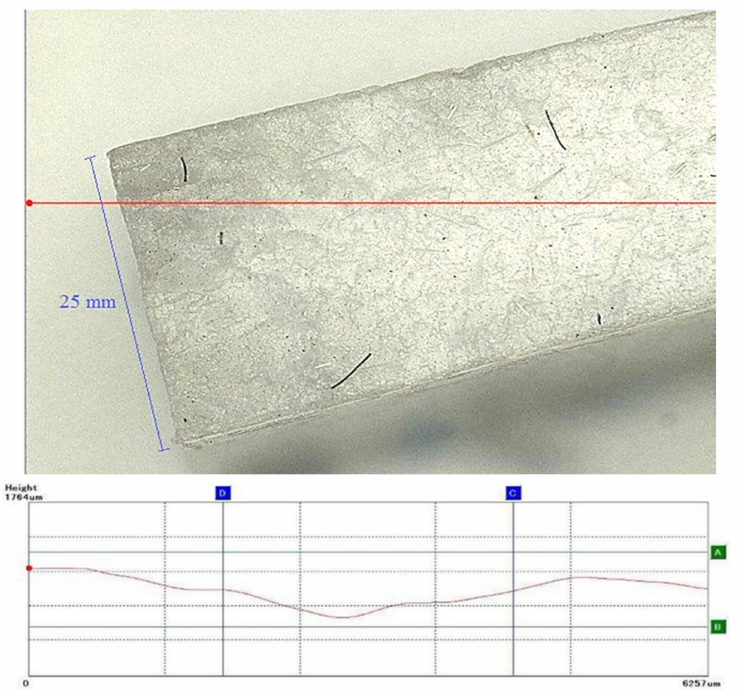
Figure 6. Glass fiber length and distribution in GF-PP composites using 3-D surface